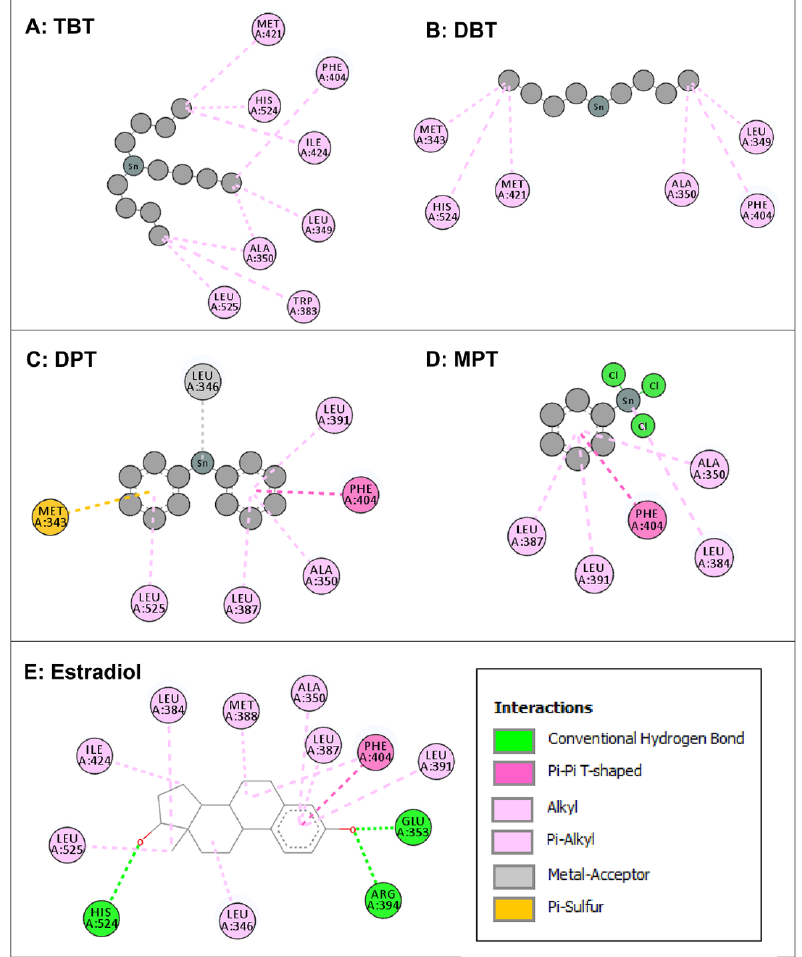
Figure 4. Two-dimensional interaction maps of amino acid residues of estrogen receptor (ER α ) interacting with four organotin ligands during molecular docking in the ligand-binding site of ER α . Amino acid residue interactions of the bound native ligand of ER α (estradiol) are also shown. Tributyltin (TBT, Panel A ); dibutyltin (DBT, Panel B ); diphenyltin (DPT; Panel C ); monophenyltin (MPT, Panel D ); and estradiol (Panel E ). Amino acid residues with alkyl or pi-alkyl bonds are indicated in light pink color, an amino acid with pi-sulfur bond is indicated in yellow color, amino acids with pi-pi T-shaped bond are indicated in dark pink color, and an amino acid with a metal acceptor bond is indicated in grey color. Interactions box: the depicted colors for interaction legends apply to all five interaction maps in the figure.